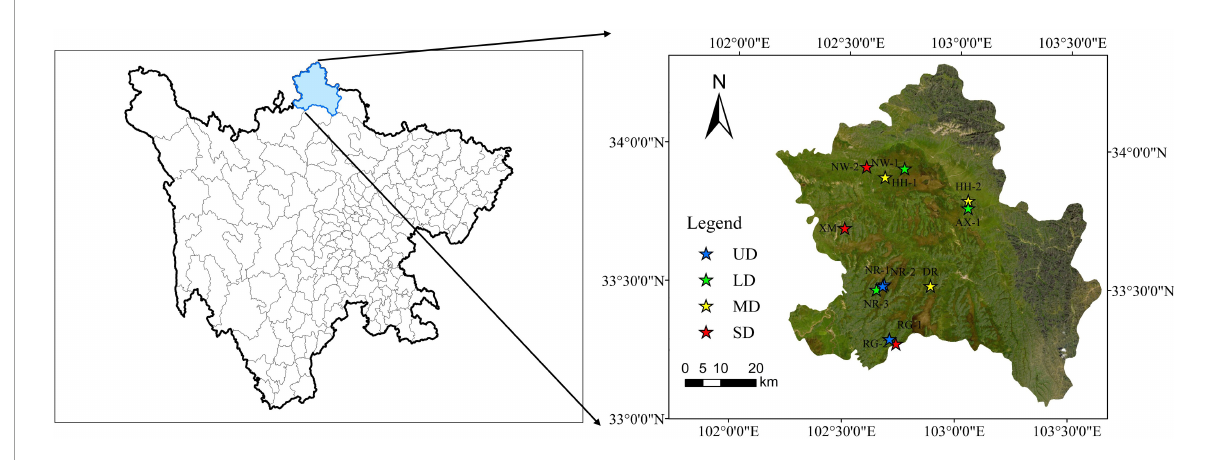
FIGURE1 Locations of the sampling sites in the Zoige Plateau. The left panel is the location of Zoige in Sichuan Province, and the right panel is the location of the sampling point in Zoige. UD, undegraded wetland; LD, lightly degraded wetland; MD, moderately degraded wetland; SD, severely degraded